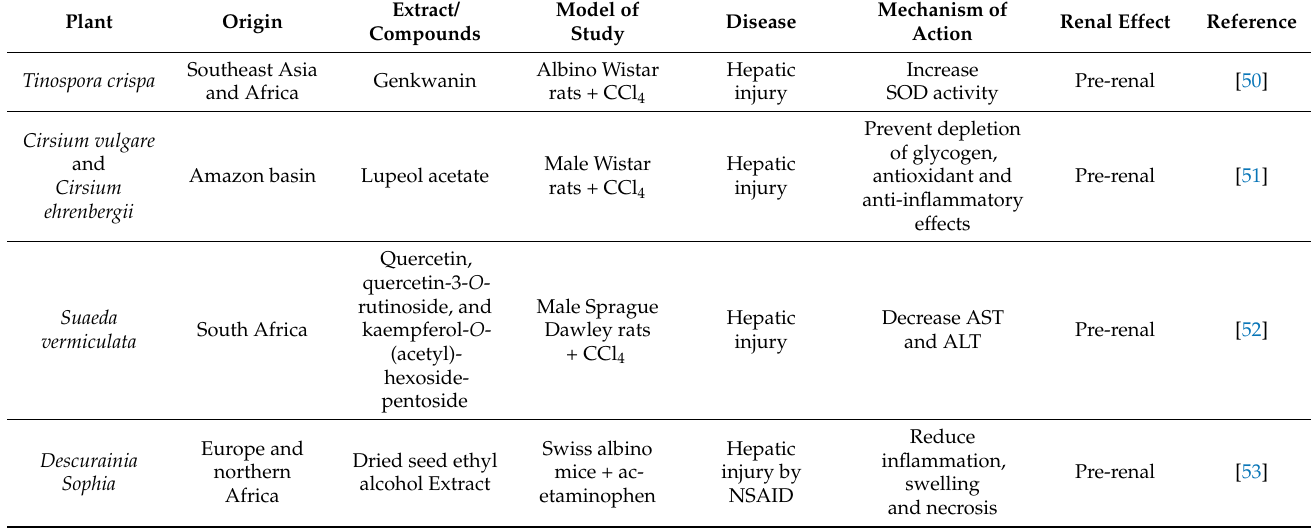
Table 1. Plants and their activity against pre-renal, intrinsic, and post-renal